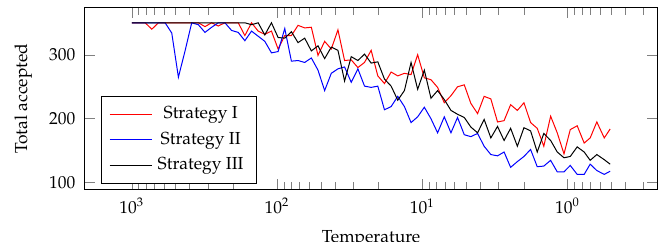
Figure 12. Total number of accepted solutions for each temperature.